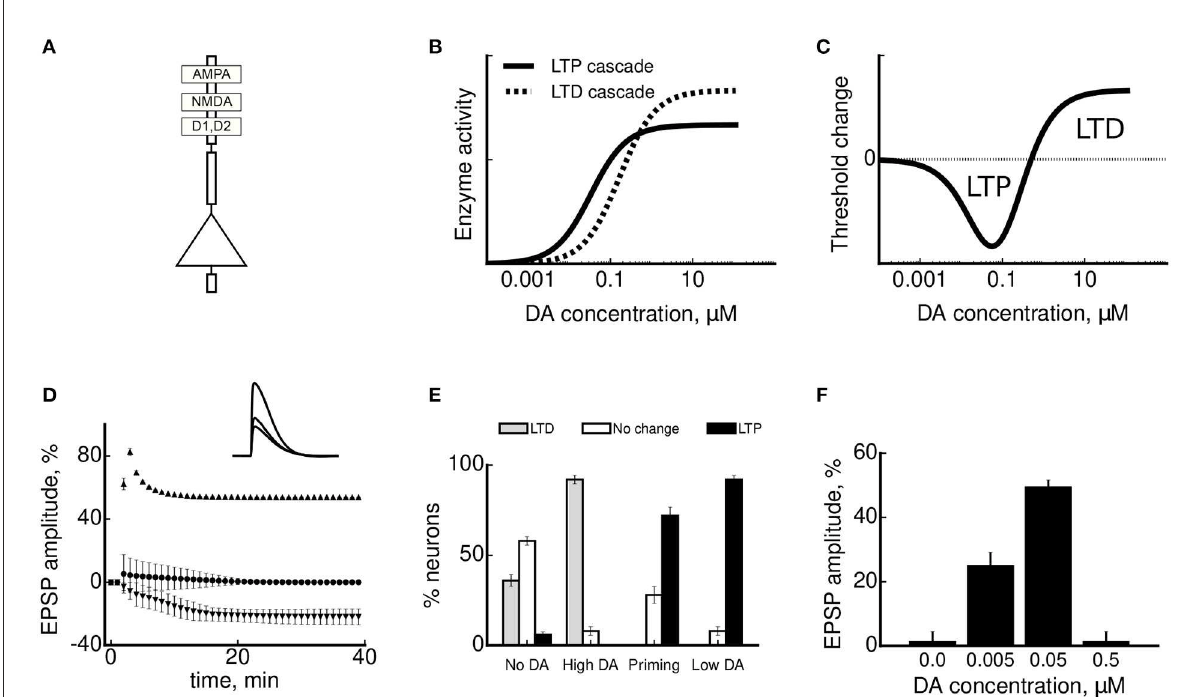
FIGURE3 A model of DA-modulated synaptic plasticity and simulation results. (A) A schematic representation of a multicompartment model of pyramidal neurons with AMPA, NMDA, D1 and D2 receptors. (B) A molecular cascade for LTP is facilitated at lower DA concentrations by D1 receptors (shown by the full black line). A molecular cascade for LTD is facilitated at higher DA concentrations by D2 receptors (dashed line). (C) The plasticity threshold between LTD and LTP shifts as a function of a difference between the activities of the two molecular cascades in (B) , resulting in a U-shaped net effect of DA concentration on synaptic plasticity. A negative threshold change corresponds to its shift to lower stimulation frequencies in Figure 2B and facilitation of LTP. Conversely, a positive change facilitates LTD. (D) Synaptic plasticity in the model neurons (measured by the amplitude of somatic EPSP ± SD) as a result of tetanic stimulation at low (3 Hz, shown by downward triangles), intermediate (50 Hz, circles) and high (300 Hz, upward triangles) stimulation frequencies. Inset: mean EPSP amplitude 40 min after stimulation in the three cases. (E) Dopaminergic modulation of synaptic plasticity near LTD/LTP threshold. The bars show the proportion of simulated neurons that underwent LTD (in gray), no change (in white) or LTP (in black), depending on DA conditions. (F) An inverted-U-shape dependence of the LTP amplitude for different concentrations of DA, as observed experimentally by Kolomiets et al. (2009). The plots are adapted with permission from Sheynikhovich et al.